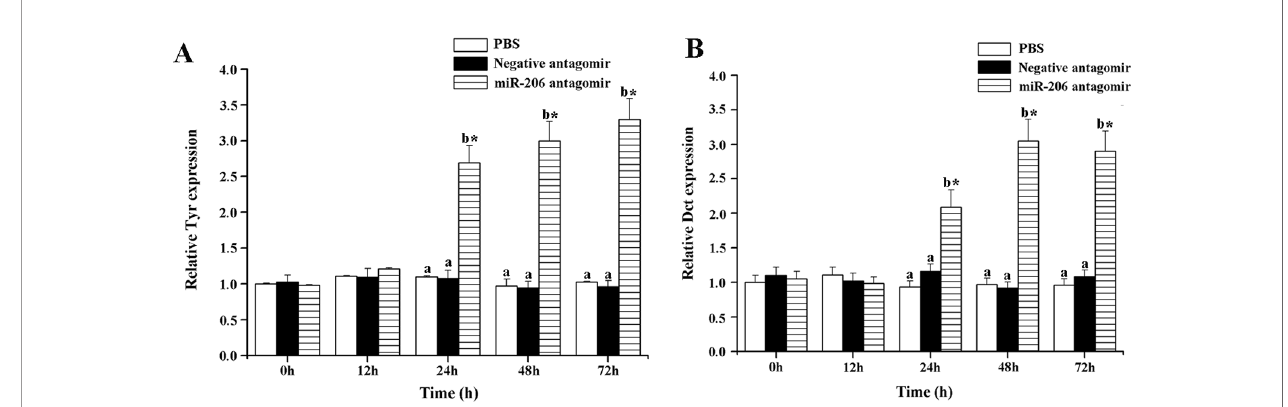
FIGURE 4 | Effect of miR-206 silencing on the expression of Tyr (A) and Dct (B) genes. Asterisk (*) indicates a signi fi cant difference ( P < 0.05) in the same treatment before and after injection with a paired-samples t-test. Different lowercase letters show signi fi cant differences among treatments at each sampling point ( P < 0.05, Duncan's multiple